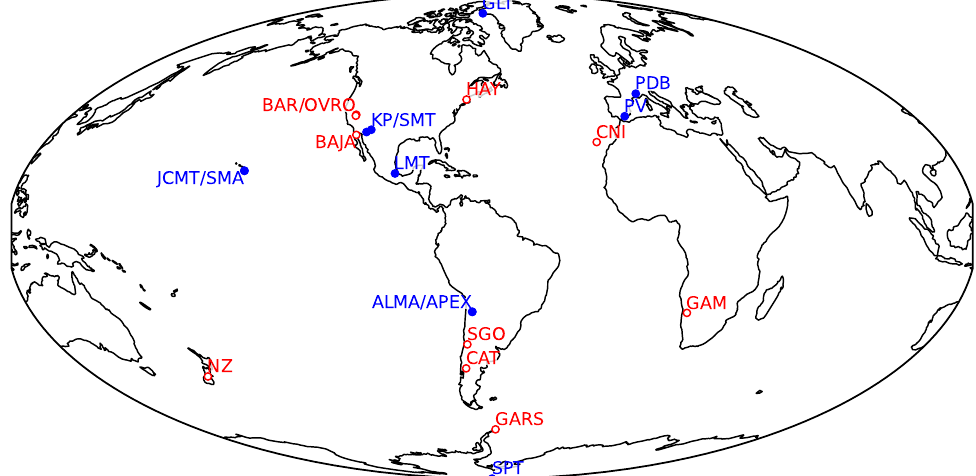
Figure 2. Station locations for Challenge 1 and 2. Stations in blue form the EHT2022 array, and stations in red are added to EHT2022 to form a reference array ngEHT1. The new station locations are near the National Astronomical Observatory in Baja California, Mexico (BAJA); Barcroft Field Station in California, USA (BAR); Cerro Catedral in R’io Negro in Argentina (CAT), La Palma, part of the Canary Islands, Spain (CNI); the Gamsberg in Namibia (GAM), the German Antarctic Receiving Station O’Higgins in Antarctica (GARS); Haystack Observatory in Westford, MA, USA; Canterbury, New Zealand (NZ); Owens Valley Radio Observatory in California, USA (OVRO); and Santiago, Chile (SGO). See Raymond et al. [67] for details, e.g., weather statistics for each